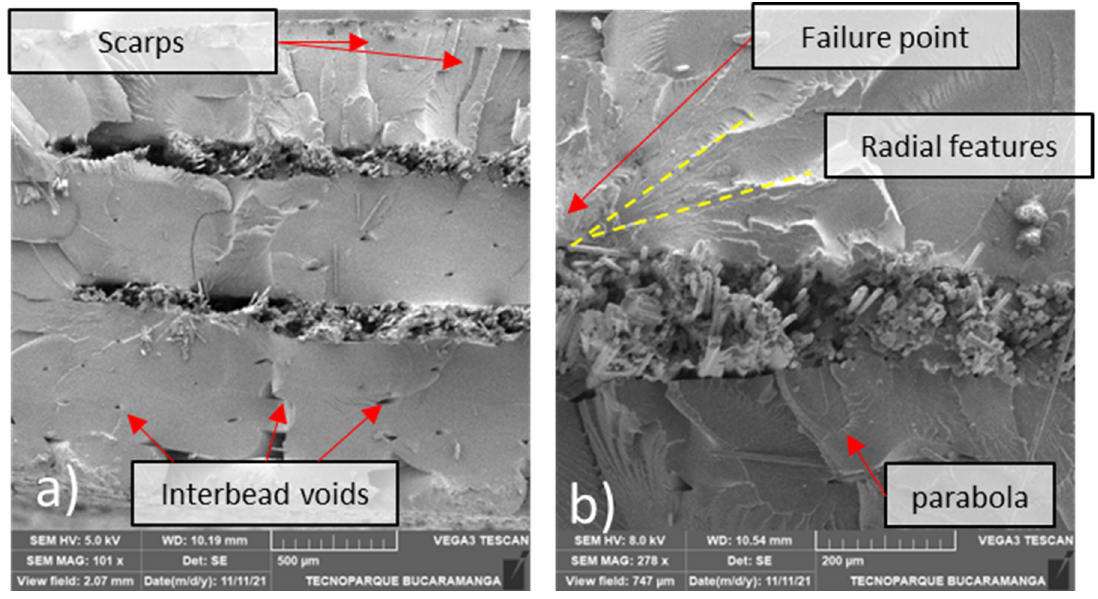
Figure 17. Flat 0° 4/16. ( a ) Wide view at 161× ( b ) Zoomed at fiber region.